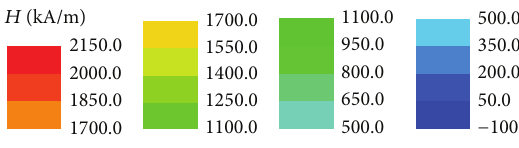
Figure 37: Scale of